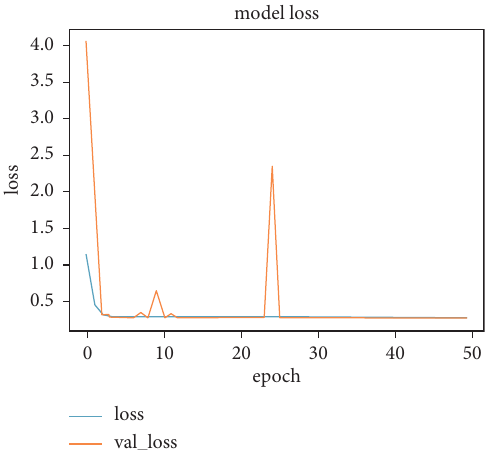
Figure 18: The loss rate of action idea EEG in dynamic state during model training.